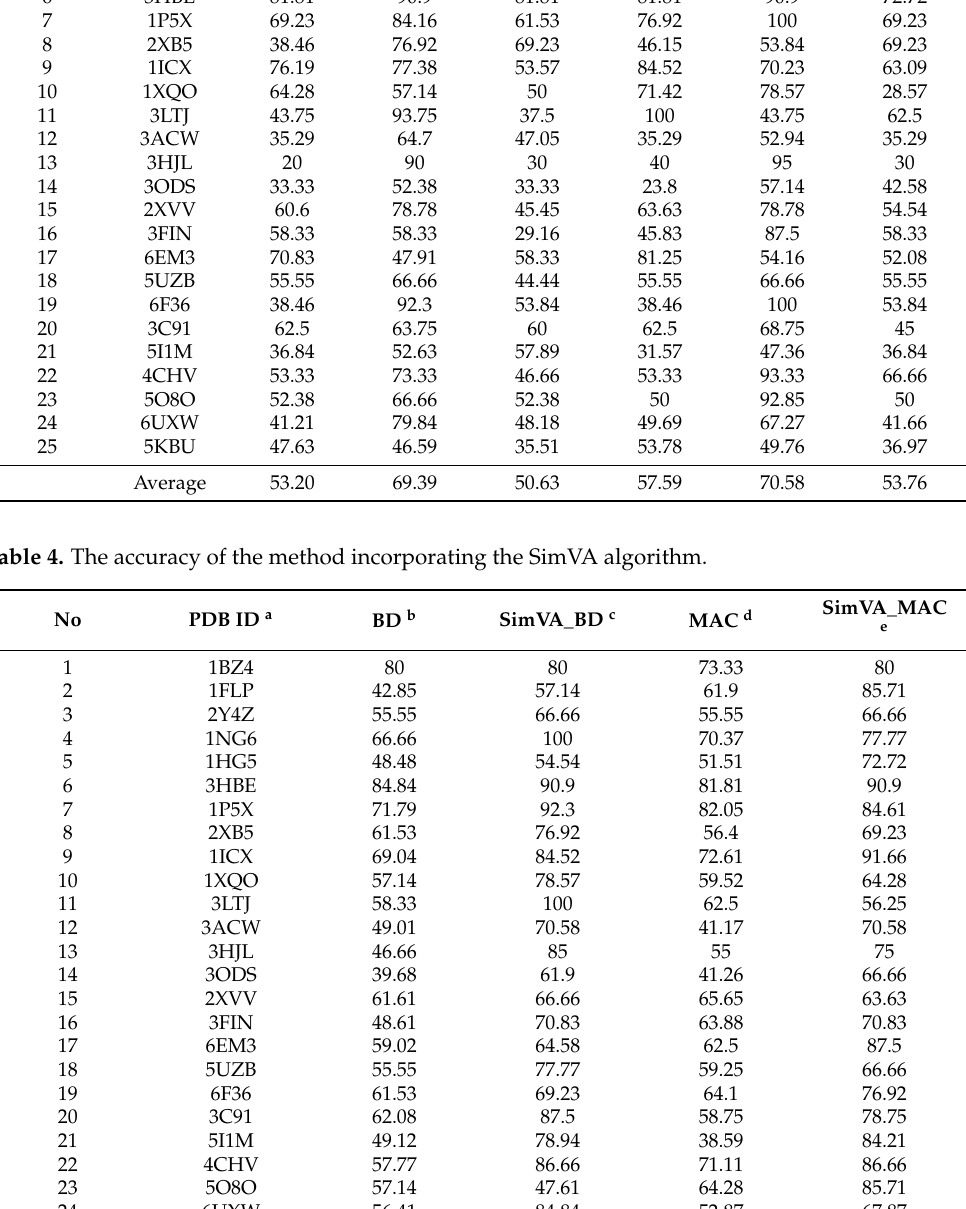
a the PDB ID of the protein; b the total accuracy obtained from three mathematical-based features using BD scoring function; c the accuracy of the SimVA algorithm using BD scoring function; d the total accuracy obtained from three mathematical-based features using MAC scoring function. e the accuracy of the SimVA algorithm using the MAC scoring